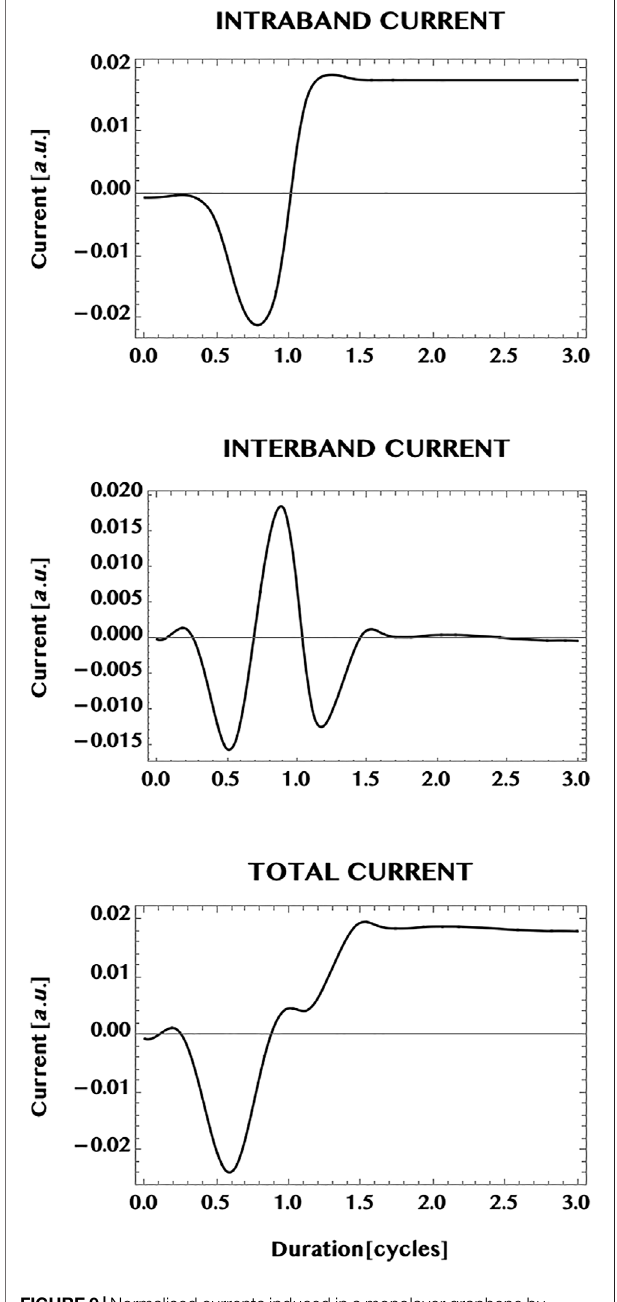
FIGURE 9| Normalised currents induced in a monolayer graphene by an ultrashort laser pulse (with the same pulse parameters as in Figure 7 ). The upper panel: intra band current; the middle panel: inter band current.Thetotalcurrentisshowninthebottompanel.Itisdominated by the intra band current that shows a near steady state by the end of the pulse, at 1.5 cycles, and after the pulse is over. The mild modulation seen to be present could be an effect of the reduced “ coherence ” (or correlation) of the inter band current by the 2D dispersion effect of the integrated sum of k -dependent inter band coherence weighted by the 2D current operator. This should becontrasted with the possible effects of “ quantum con fi nement ” along the width dimension and the band-gap minimum, in the case of the armchair ribbon (cf. Figure 10